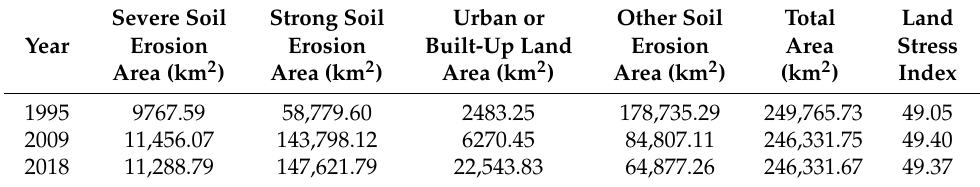
Figure 4. The area ratio of different soil erosion degrees in Hetian. Table 8. Results of the land stress index in